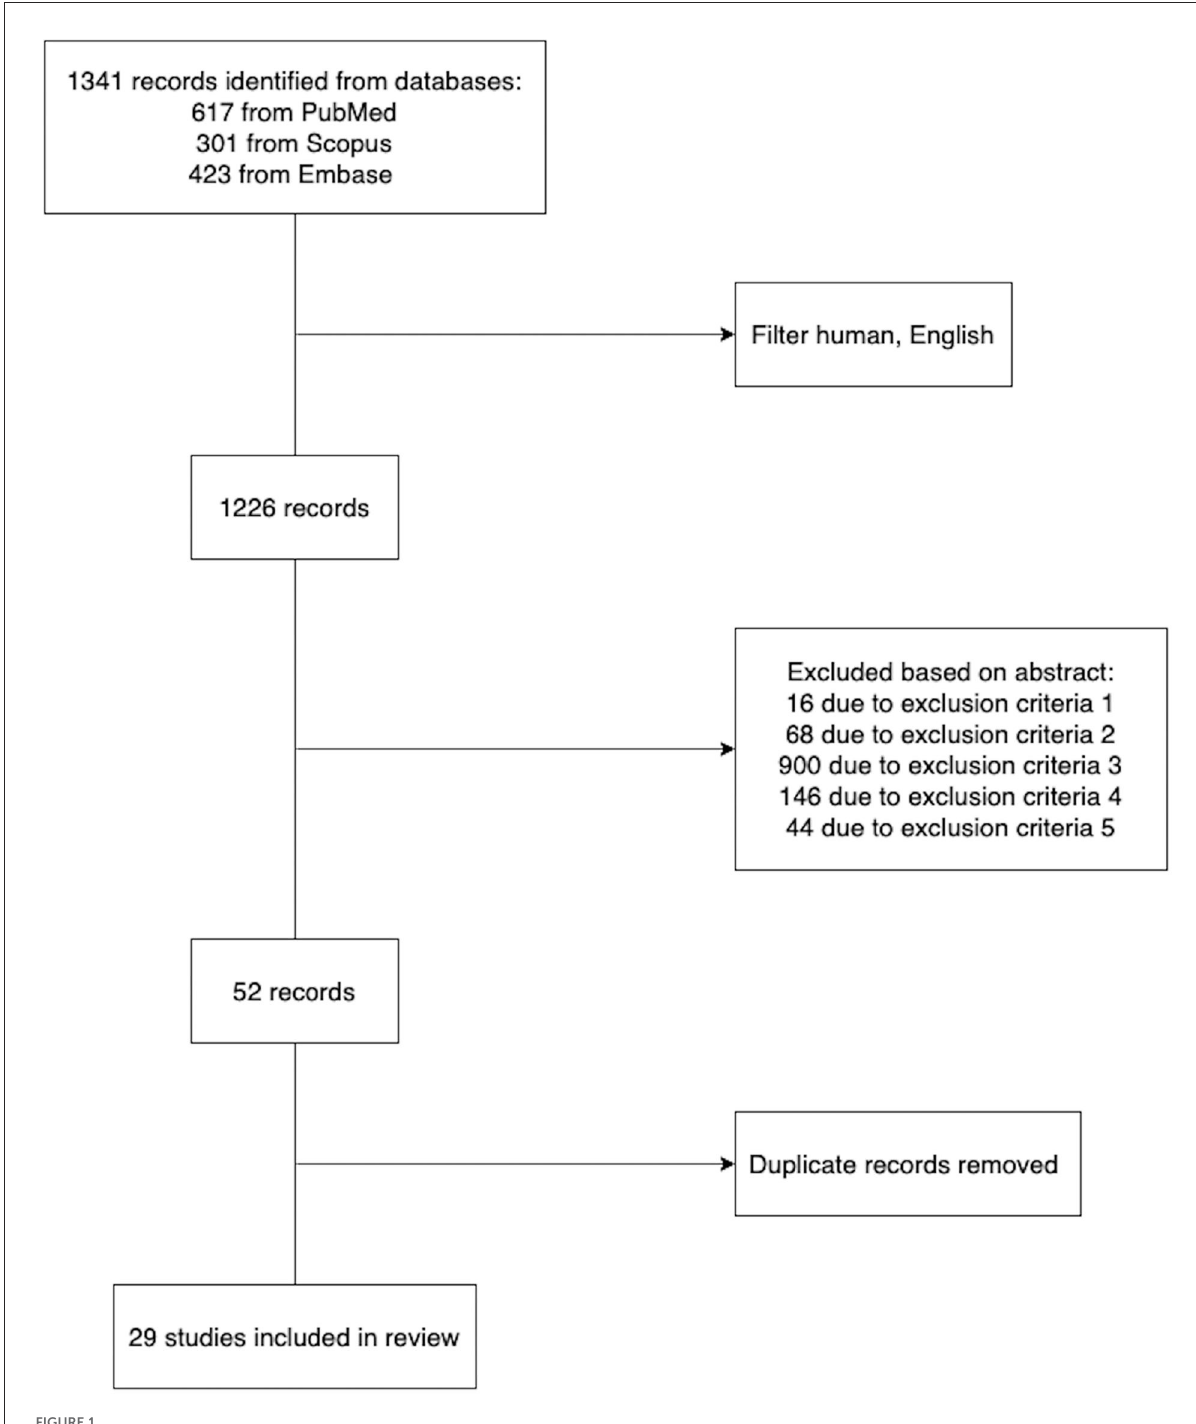
FIGURE1 Selection of studies. The five exclusion criteria were explained in detail in Section 2.